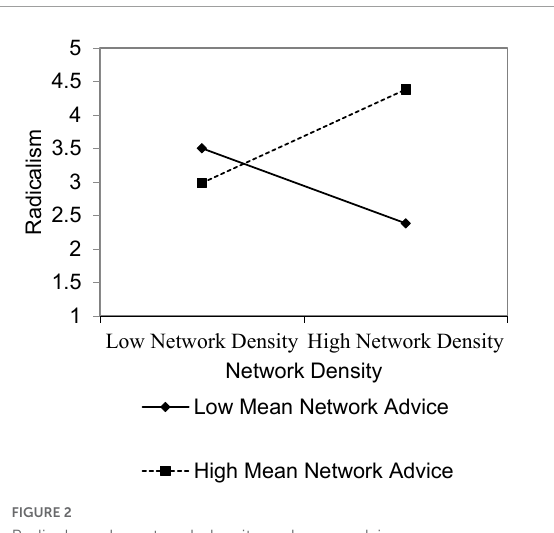
FIGURE2 Radicalness by network density and mean